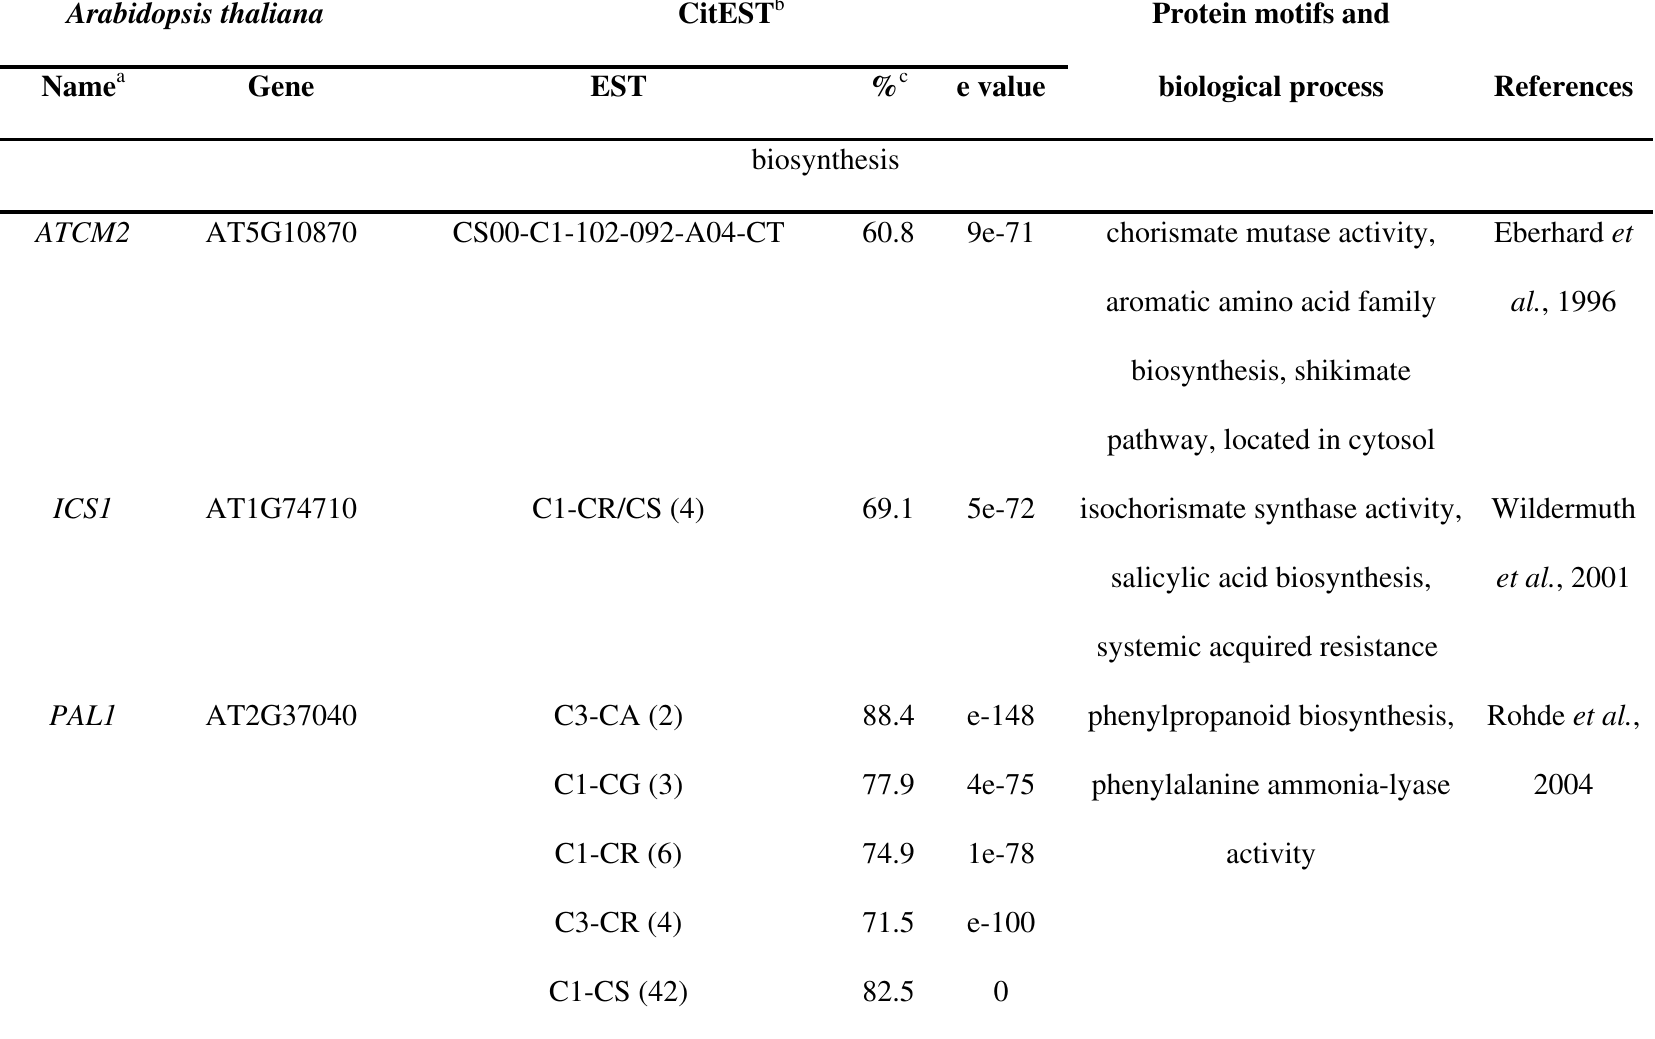
Table S14 – Citrus ESTs with homology to genes involved in salicylic acid metabolism in